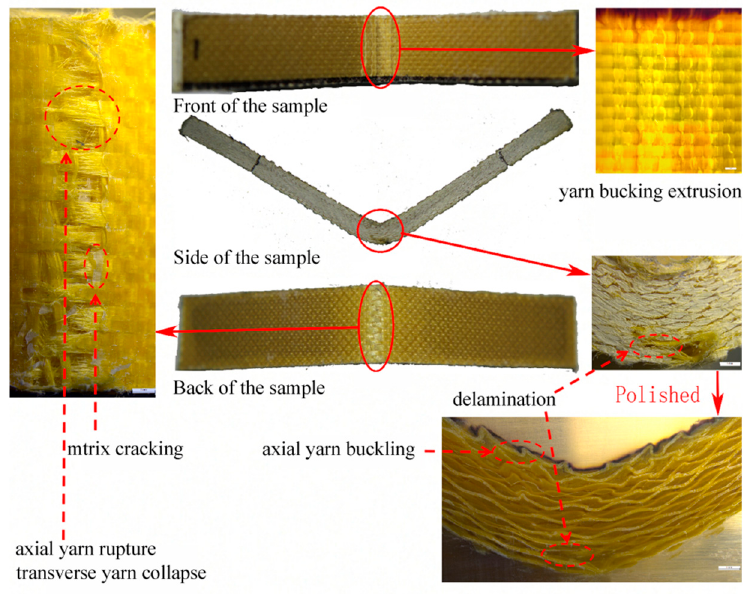
Figure 14. Bending failure morphology of 2D plain laminated Kevlar/EP armor material.